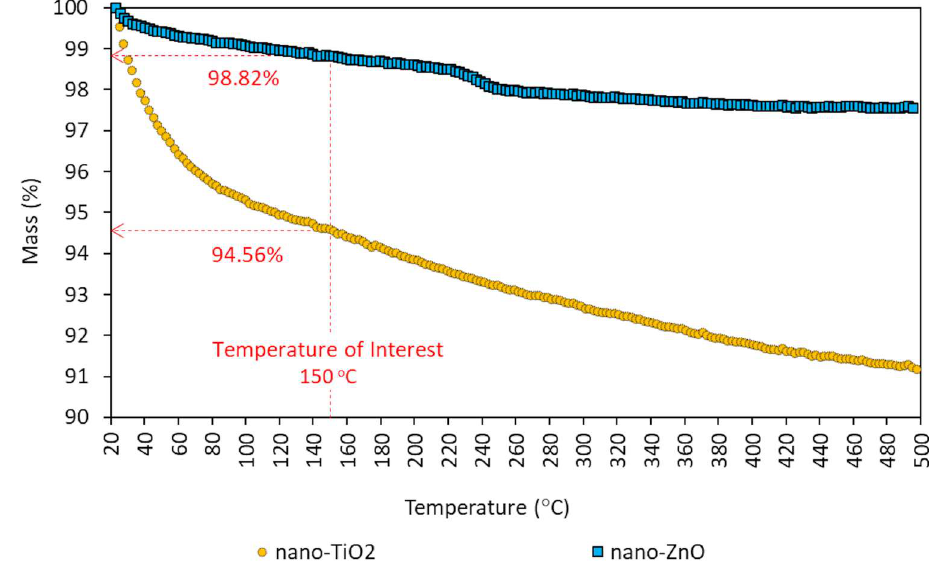
Figure 3. Thermogravimetric curve in nitrogen atmosphere: nano-TiO 2 and nano-ZnO.